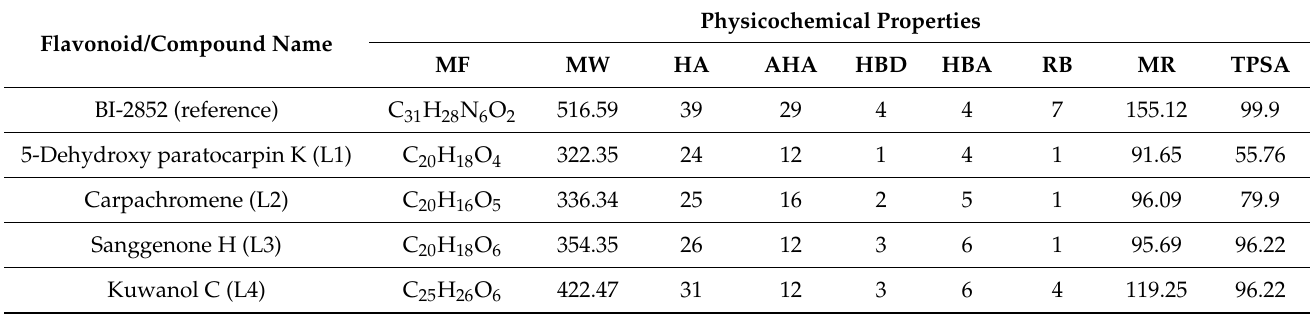
Table 1. Physicochemical properties of 4 lead flavonoids.